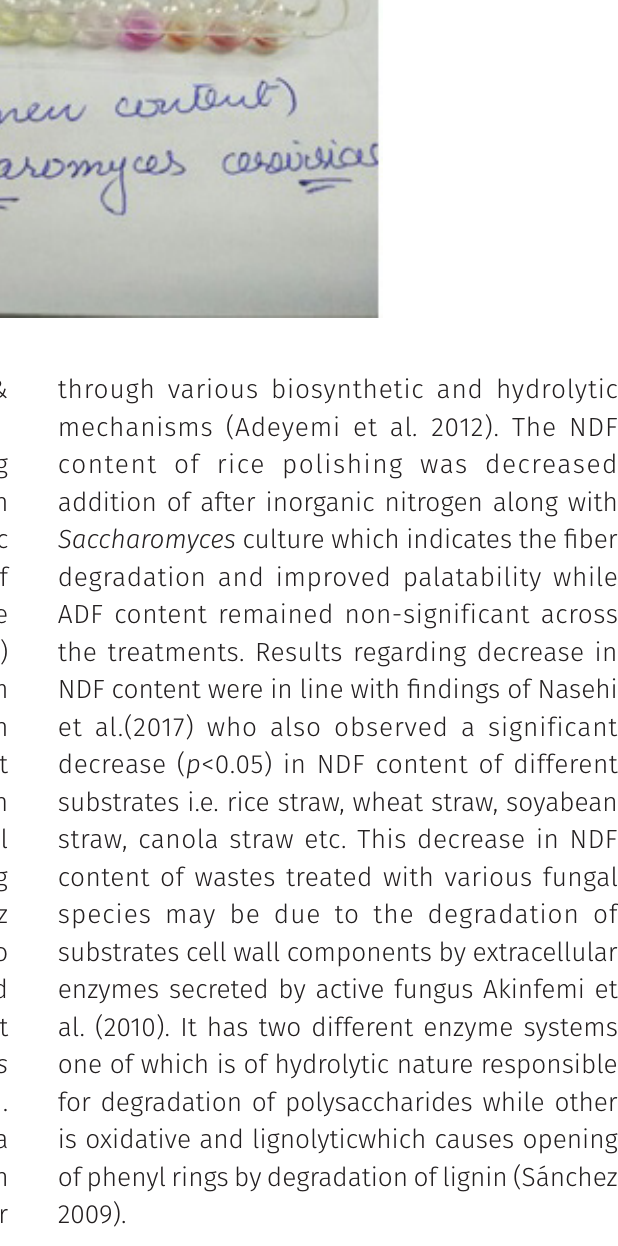
Figure 3. Generation of code with yeast plus remel